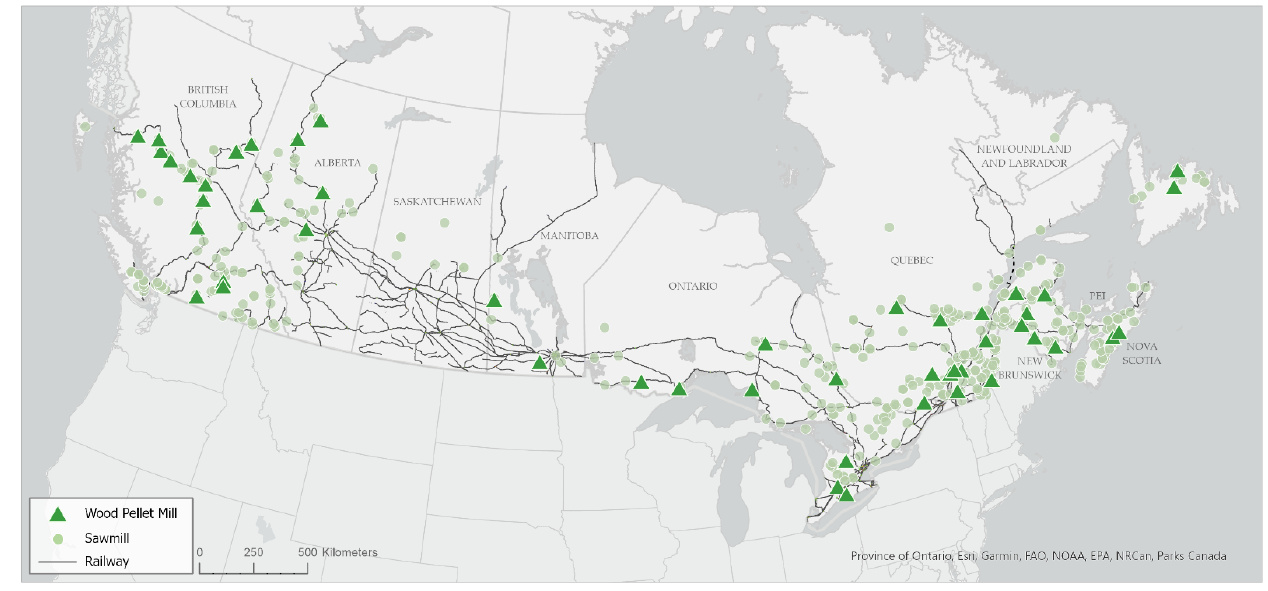
Figure 1. Location of wood pellet mills and sawmills in Canada, operational at end of 2020.